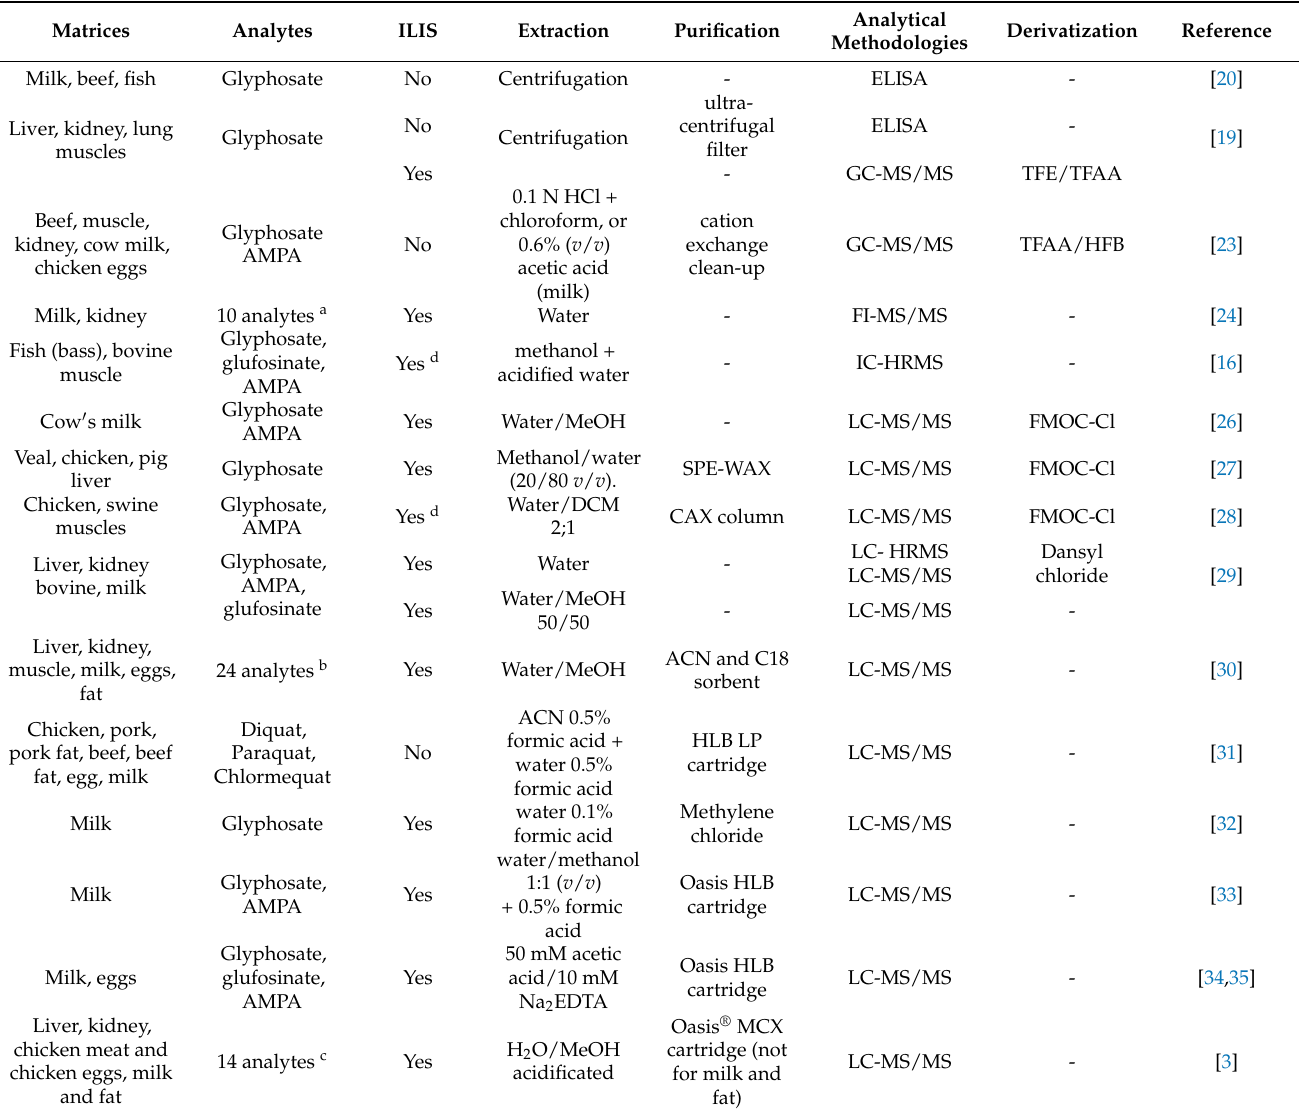
Table 1. Main characteristics of methods used for the analysis of polar pesticides in food of animal